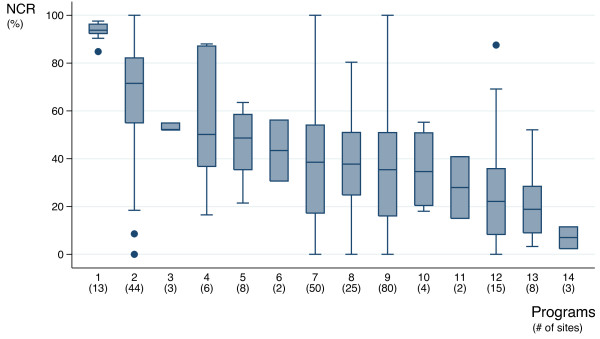
Site performance dispersion by PMTCT program: Nevirapine Coverage Ratios (NCR). Boxplots are displayed for programs including at least two sites (n=14) as follows: the median is represented by a horizontal line within each box, which represents the interquartile range (IQR) comprising data between the 25th and 75th percentiles. Whiskers extend to the 1.5*IQR beyond each box and circles represent outliers.